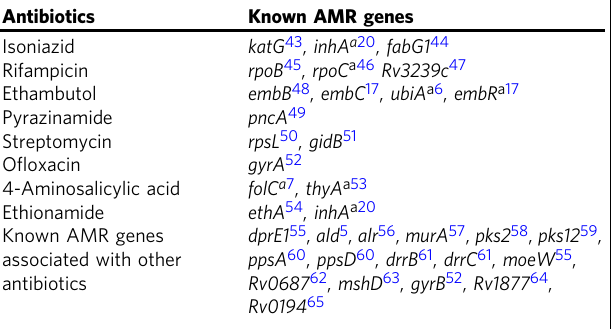
Table 1 Known AMR genes uncovered by machine